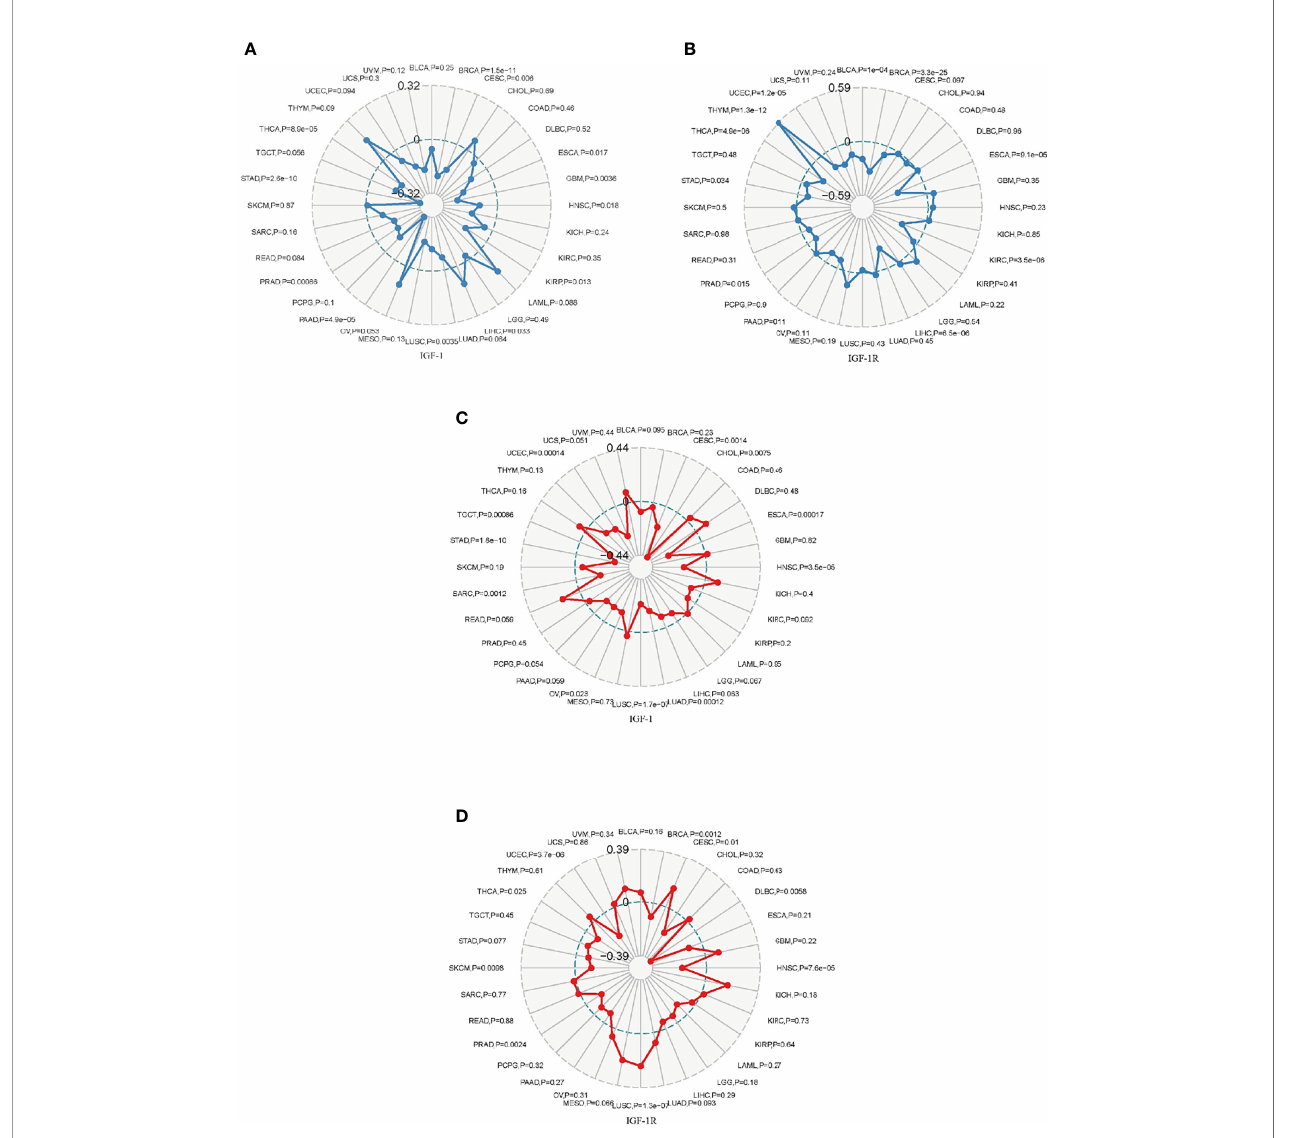
FIGURE 7 | Radar map plotting the correlation of tumor mutation burden (TMB) (A) and microsatellite instability (MSI) (B) with IGF-1 expression across 33 cancer types. Radar map plotting the correlation of tumor mutation burden (TMB) (C) and microsatellite instability (MSI) (D) with IGF-1R expression across 33 cancer